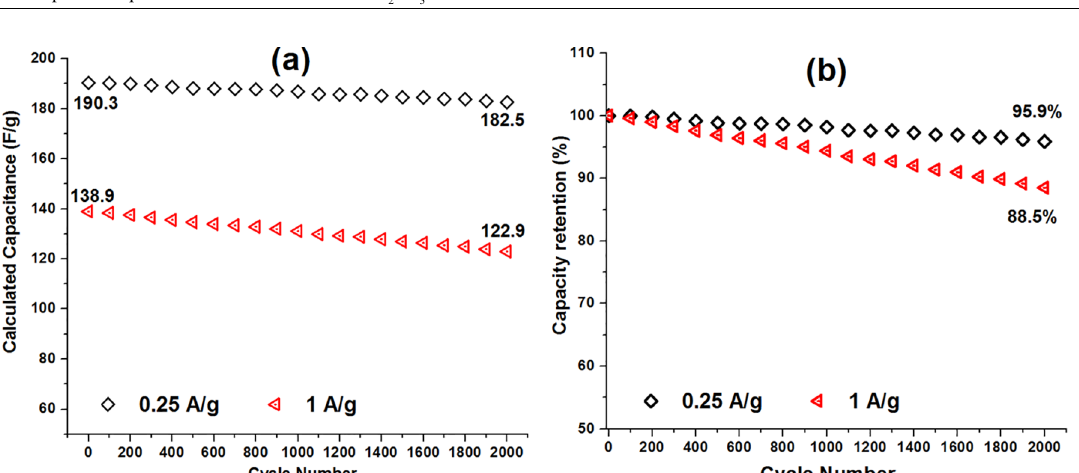
Fig. 7. (a) Calulated specific capacity valuess and (b) capacity retentions during 2000 GCD cycling at the discharge loads of 0.25 and 1 A g